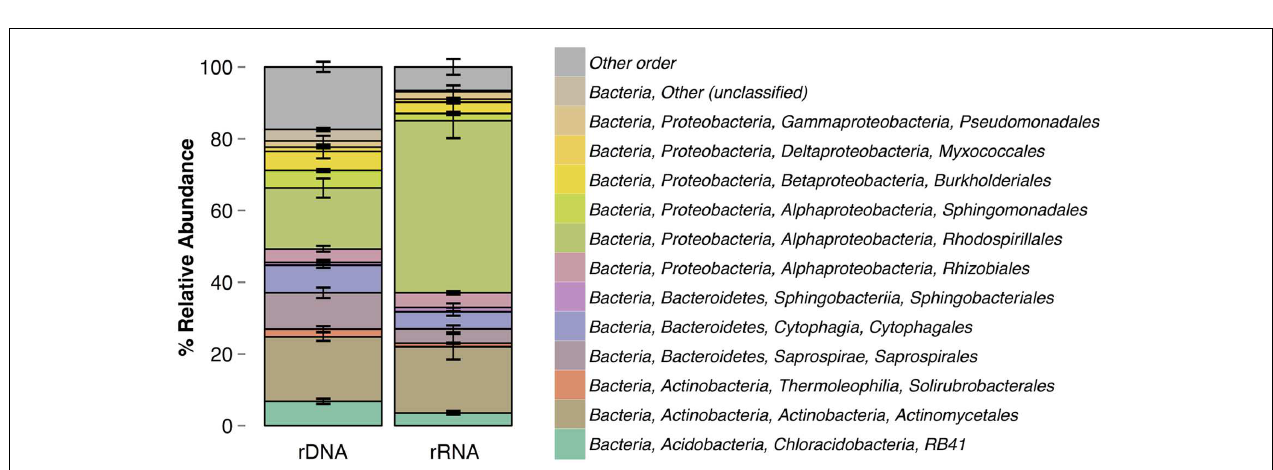
FIGURE 1 | Conceptual representation of model parameters for the ecological community that is randomly sampled. (A) Example taxa abundance distributions. The shape of the underlying rDNA taxa abundance distribution can be varied. (B) Bacterial cells with chromosomal DNA and varying number of ribosomes per cell. Activity intensity ( m ( k )), or the number of rRNAs per rDNA, can be constant or vary across rDNA abundance k . (C) Example taxa abundance distributions with activity profiles ( α ( k )) shown in red. The activity profile specifies the proportion of active taxa at each abundance k . This can be varied such that low abundance values contain a higher proportion of active taxa than high abundant values (left) or vice versa (right).